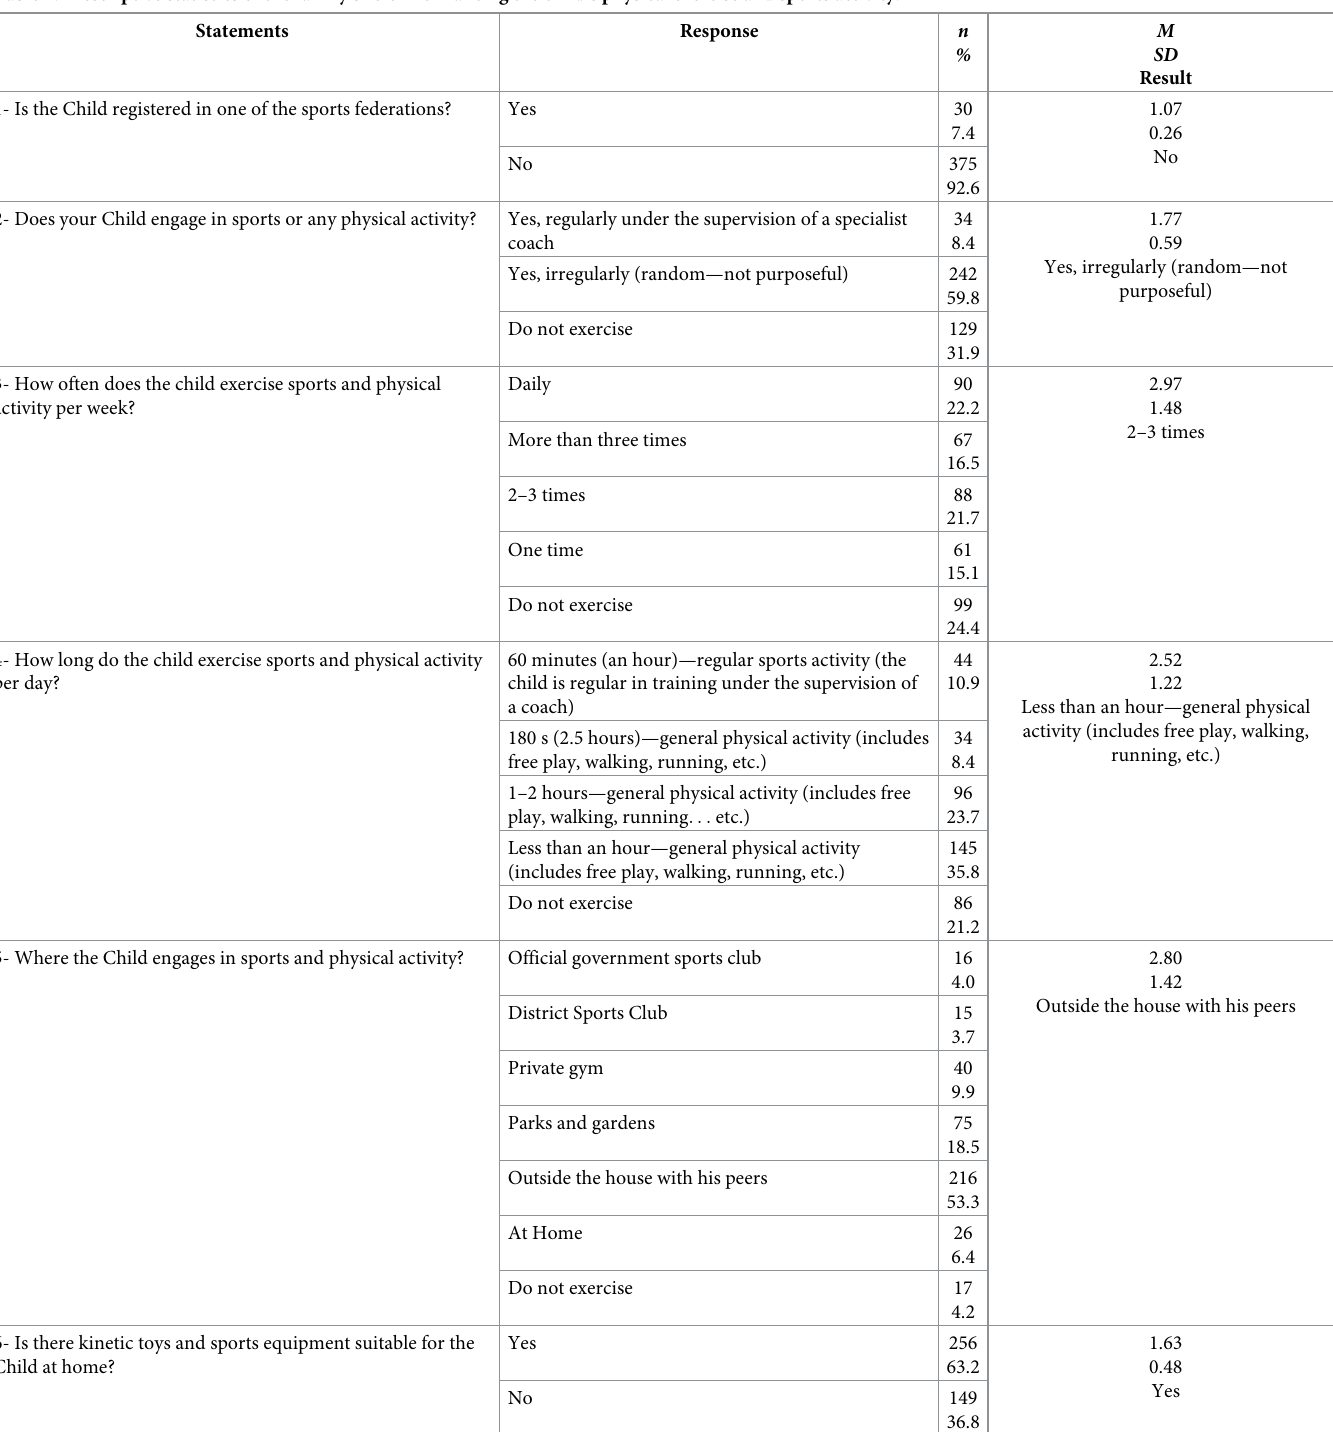
Table 1. Descriptive statistics of the family’s role in enhancing the child’s physical exercise and sports